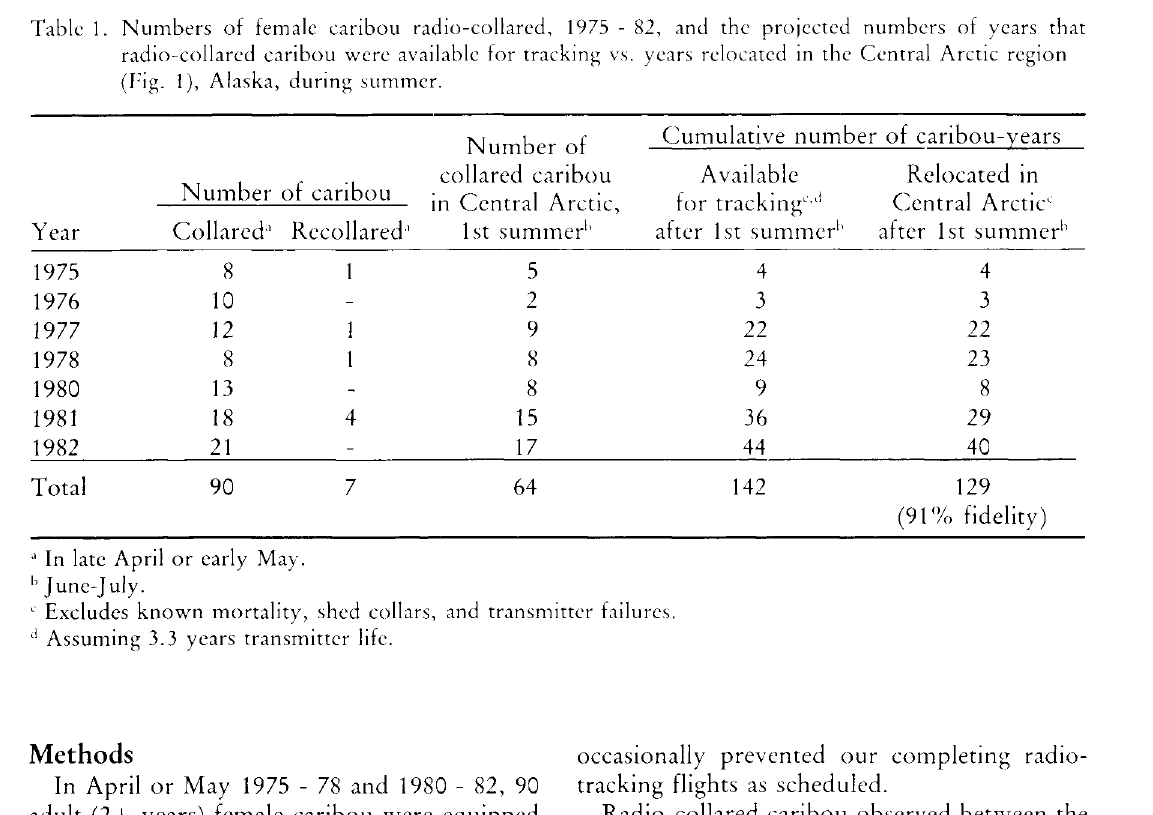
Table 1. Numbers of female caribou radio-collared, 1975 - 82, and the projected numbers of years that radio-collared caribou were available for tracking vs. years relocated in the Central Arctic region (Pig. 1), Alaska, during